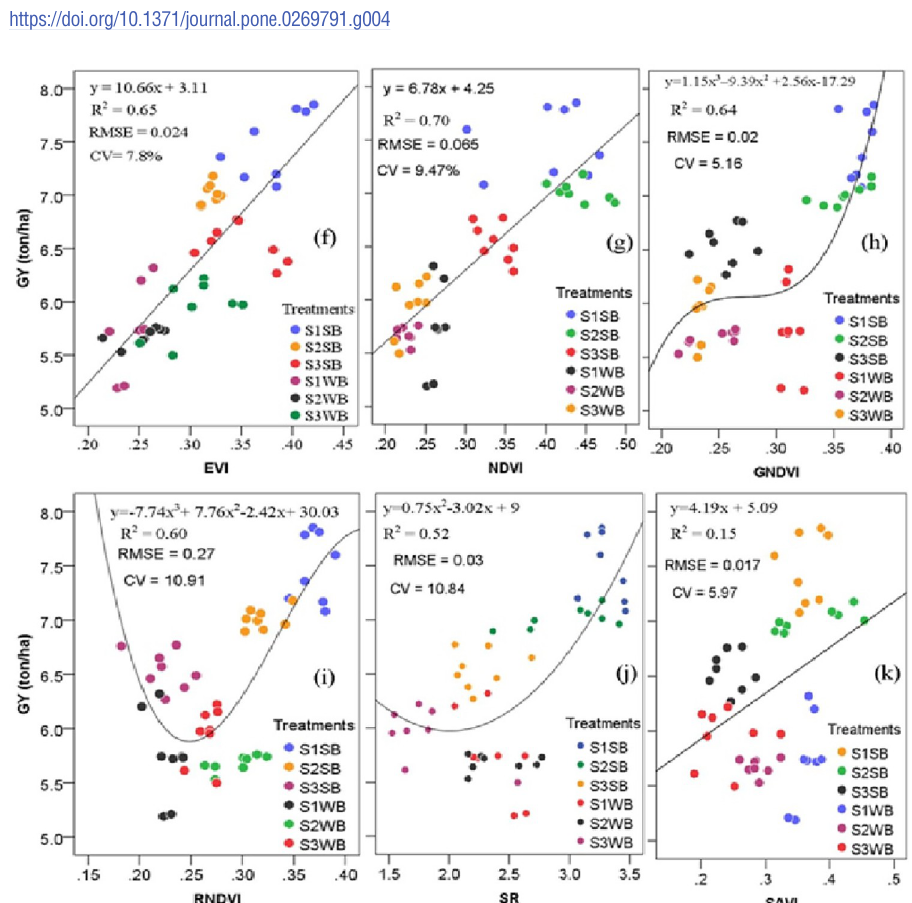
Fig 5. Connection between spectral index values and maize grain yield measured at the crop grain-filling stage (p < 0.01; the total number of samples = 48). (f) EVI, (g) NDVI, (h) GNDVI, (i) RNDVI, (j) SAVI, and (k) SR (p < 0.01; the total number of samples = 48). R 2 , coefficient of determination; CV, coefficient of variation; EVI, enhanced vegetation index; GNDVI, green normalized difference vegetation index; NDVI, normalized difference vegetation index; SR, simple ratio; RNDVI, red normalized difference vegetation index; SAVI, soil adjusted vegetation index; GY, grain yield; S1, 2–5%; S2, 5–10%; S3, 10–15%; SB, soil bund; WB: Without soil bund. https://doi.org/10.1371/journal.pone.0269791.g005 PLOS ONE | https://doi.org/10.1371/journal.pone.0269791 June 16,